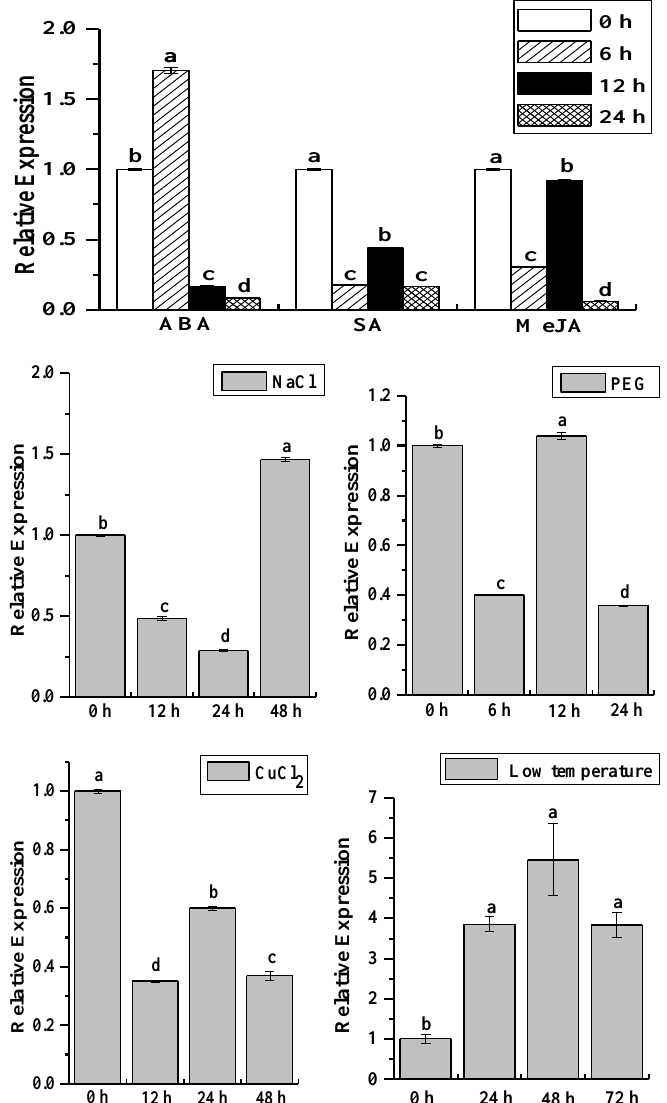
Figure 7. Relative expression of ScCAT2 after the application of exogenous plant hormone and abiotic stress. ScCAT2 transcript abundance in Yacheng05-179 tissue cultured plantlets was assessed in the presence of 100 µ M ABA, 5 mM SA, 25 µ M MeJA, 250 mM NaCl, 25% PEG, 100 µ M CuCl 2 , and 4 ◦ C low temperature. The data were normalized to the expression level of the glyceraldehyde-3-phosphate dehydrogenase ( GAPDH ) gene. All data points were expressed as the means ± standard error ( n = 3). Different lowercase letters indicated a significant difference ( p < 0.05) compared to the control, as determined with Duncan’s test. ABA, abscisic acid; SA, salicylic acid; MeJA, methyl jasmonate; NaCl, sodium chloride; PEG, polyethylene glycol; CuCl 2 , copper chloride; and low temperature, 4 ◦ C cold stress.